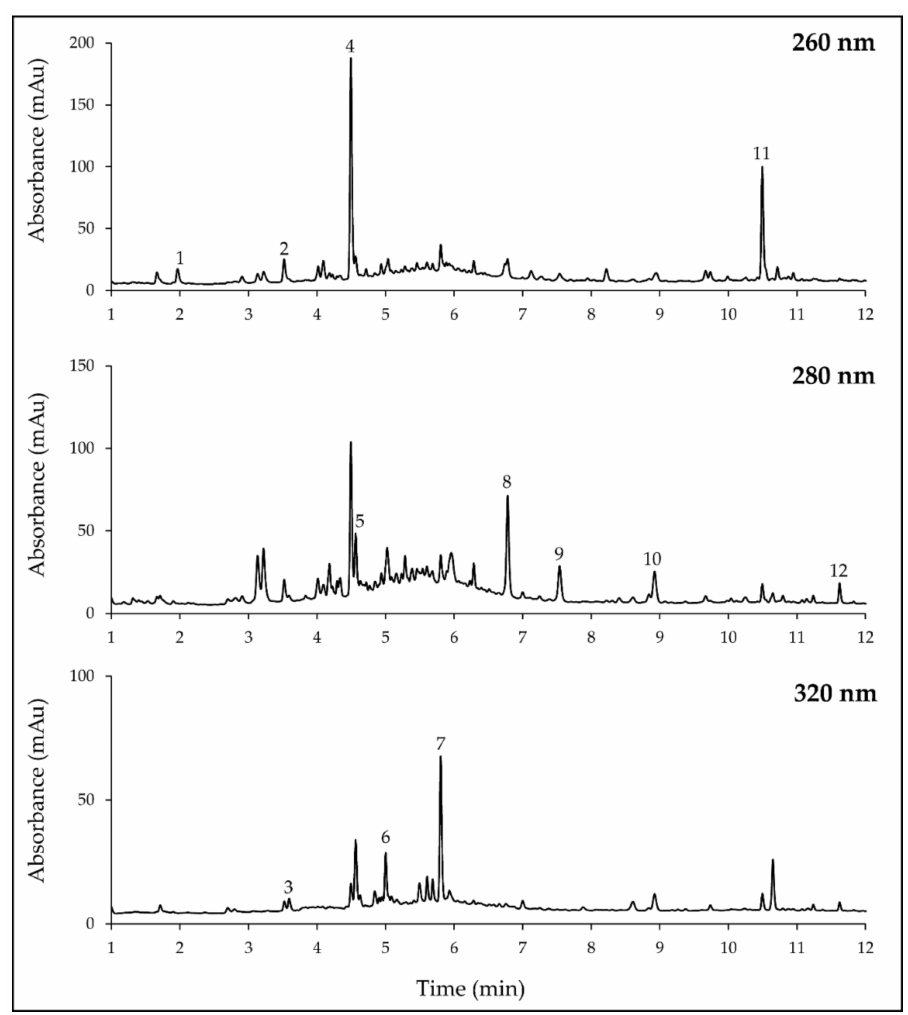
Figure 5. Chromatograms at 260, 280, and 320 nm of the active maritime pine sawdust extract obtained at 175 ◦ C. 1, protocatechuic acid; 2, vanillic acid; 3, caffeic acid; 4, coniferyl alcohol; 5, vanillin; 6, ferulic acid; 7, coniferyl aldehyde; 8, nortrachelogenin; 9, pinoresinol; 10, pinobanksin; 11, unknown; 12,